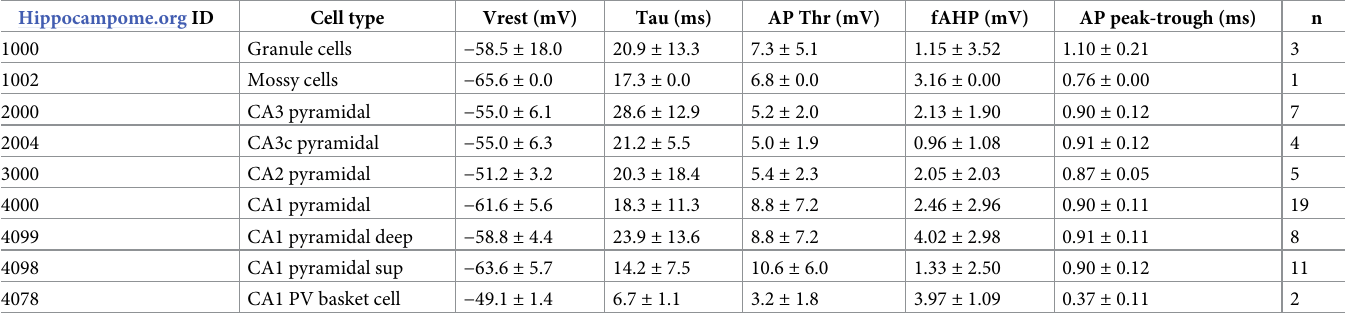
Table 1. In vivo membrane properties for hippocampal cell types (sharp intracellular recordings; values are means ± standard deviations). Hippocampome.org ID